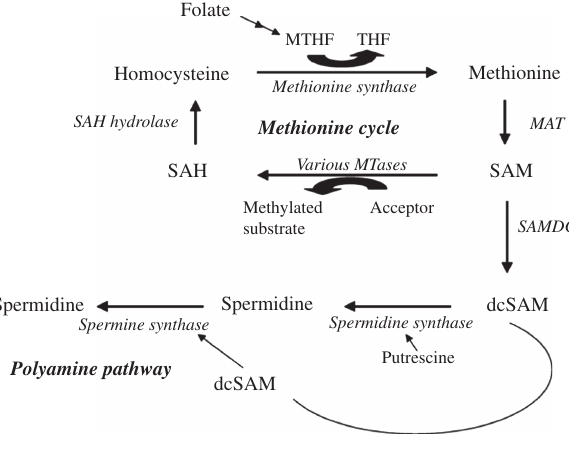
Figure 2 Folate and polyamines